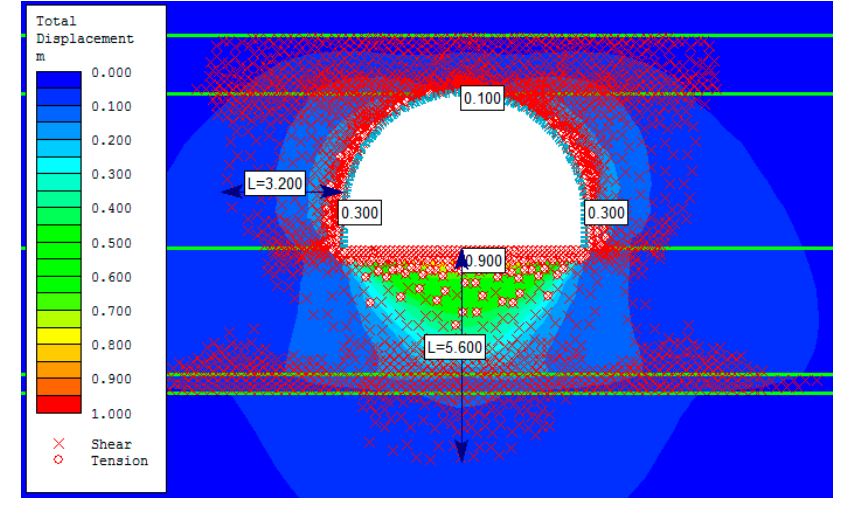
Figure 8. Model elasto-plastic with interpreted Young modulus—map of total displacement and failure mechanism around the opening.